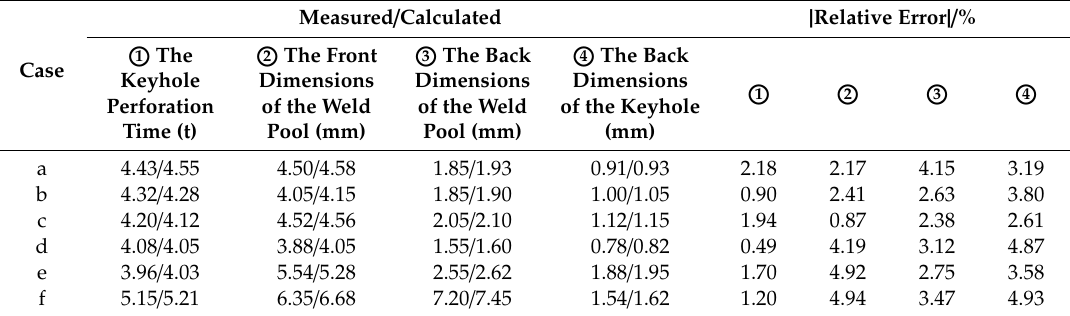
Table 5. The comparison of keyhole perforation time, the front and back dimensions of the weld pool and the back dimensions of the keyhole.